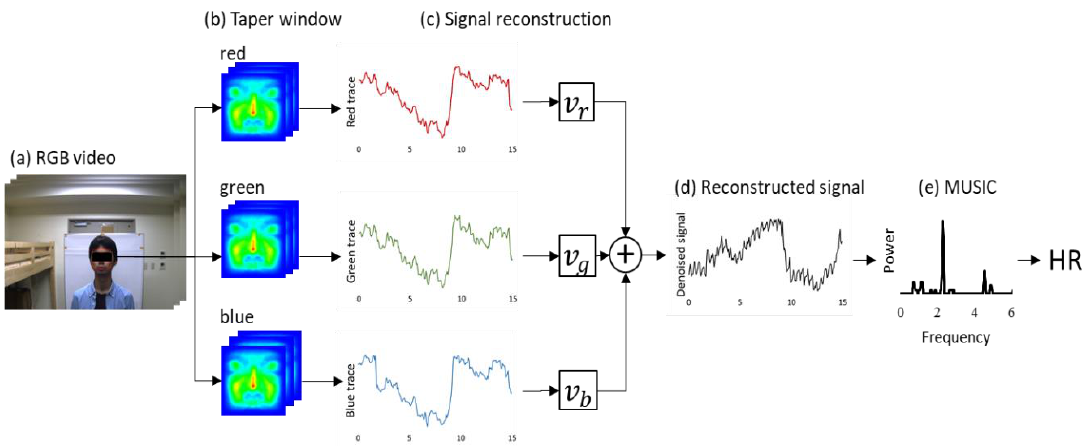
Figure 4. Block diagram of signal processing for HR estimation. ( a ) RGB video with ROI detected by OpenCV. ( b ) RGB ROI image applied to tapered window. ( c ) Raw RGB time-series data and reconstruction vector 𝑉 = (𝑣 𝑟 , 𝑣 𝑔 , 𝑣 𝑏 ) determined by kurtosis of spectra. ( d ) Reconstructed signal using V . ( e ) Power spectra obtained by MUSIC.